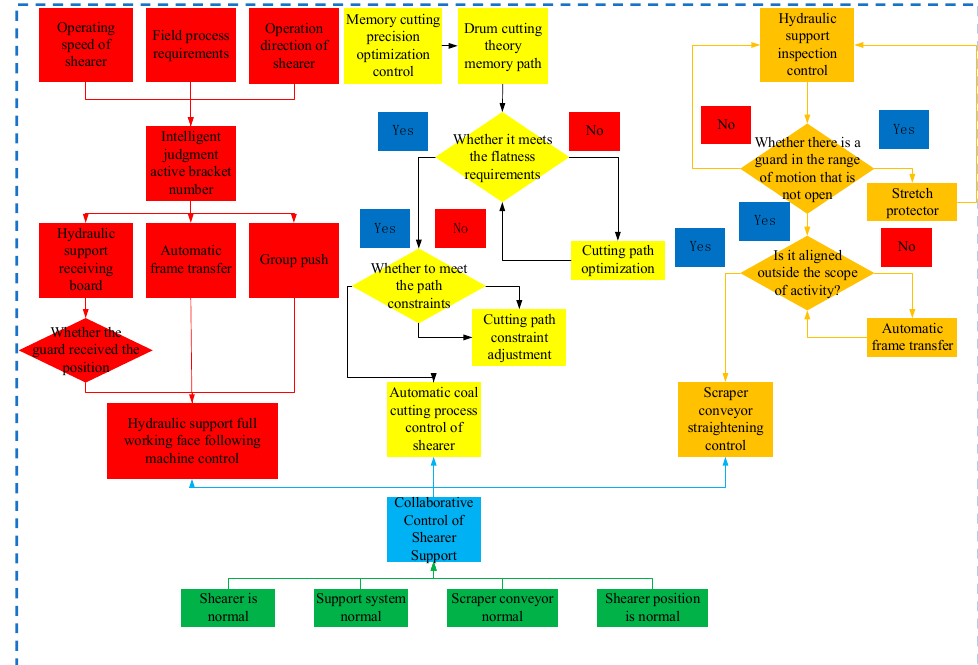
Figure 5. Process control model of fully mechanized mining equipment.